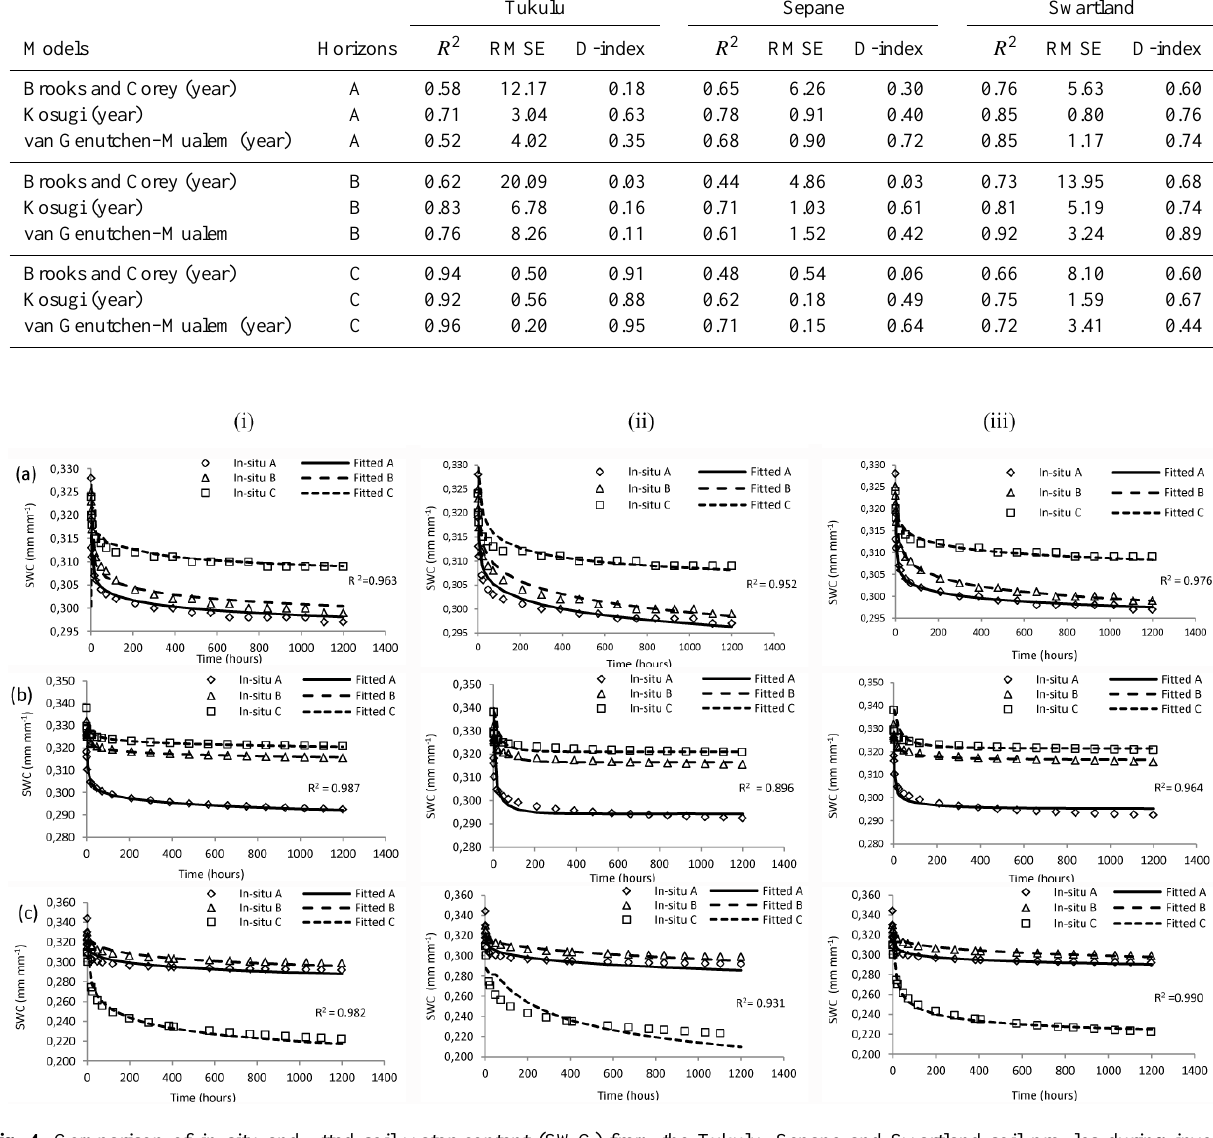
Fig. 4. Comparison of in situ and fitted soil water content (SWC) from the Tukulu, Sepane and Swartland soil profiles during inverse parameter estimation with Brooks and Corey (1964), Kosugi and van Genuchten–Mualem (1980) models using HYDRUS-1D